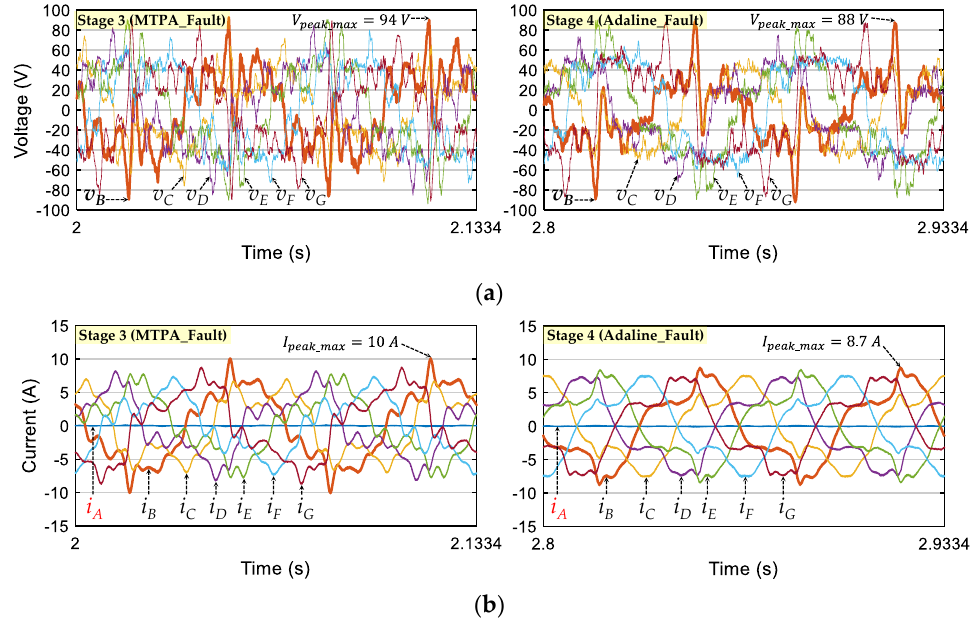
Figure 7. (Numerical result) Voltages and currents at 300 rpm in stages 3 and 4 when phase A is opened: ( a ) phase voltage references; and ( b ) phase currents.